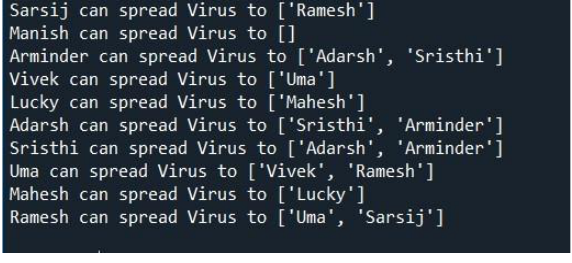
Figure 12. List of Infected individuals with patient 0 as